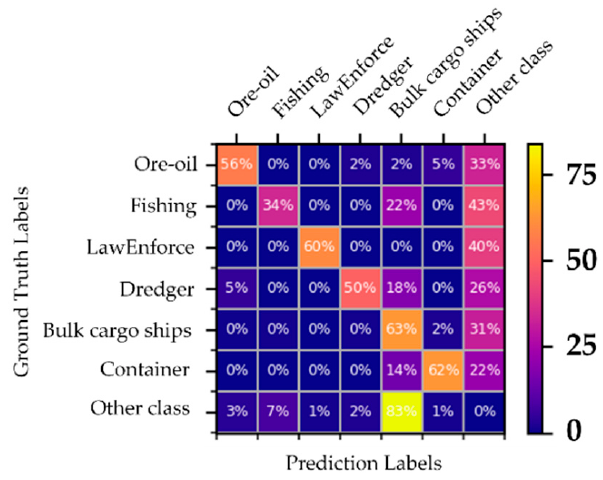
Figure 10. Confusion matrix.